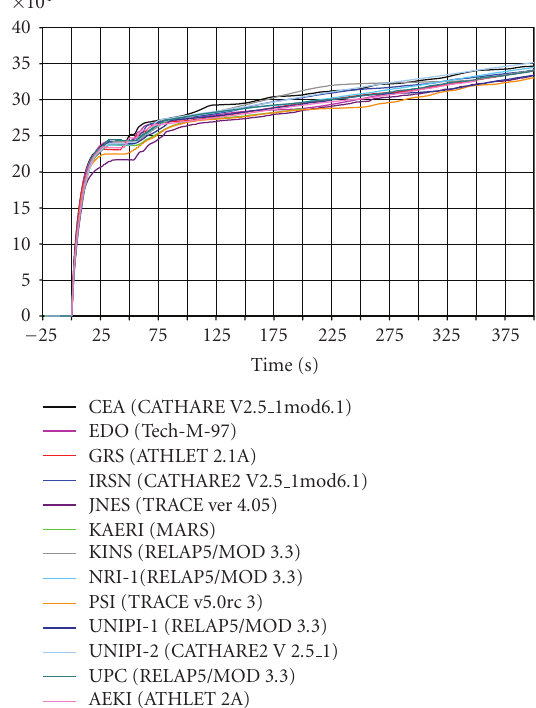
Regarding the Δ REFLOOD , the average participant has encountered that the parameters having more influence in the time of reflood are containment pressure, power